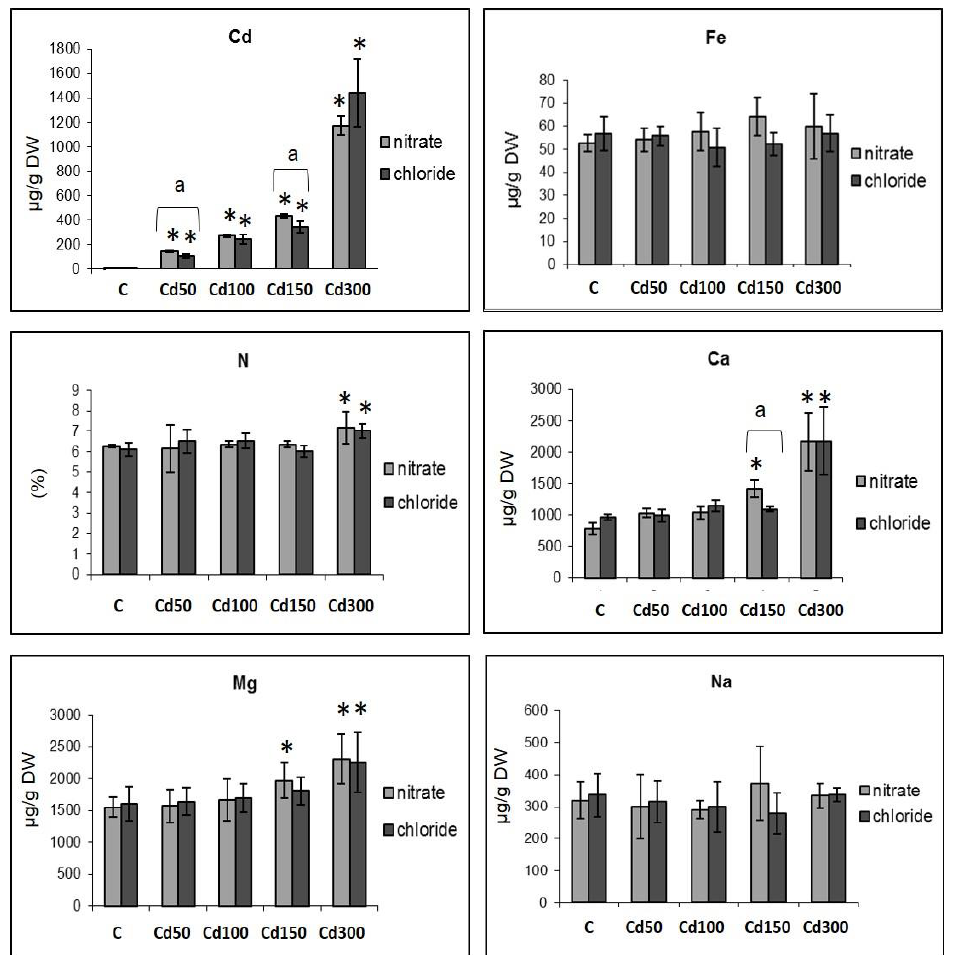
Figure 3. Effects of different doses of cadmium (0–300 mg/L) applied in the form of nitrate or chloride on the content of cadmium ( Cd ) and minerals—iron ( Fe ), nitrogen ( N ), calcium ( Ca ), magnesium ( Mg ) and sodium ( Na )—in roots of fava bean. The values represent the arithmetic mean ± standard deviation. *—the level of significance of the differences against the control (0 mg/L Cd) at p < 0.05; a—statistically significant differences between the variants of the experiment (nitrate and chlo-ride) at p < 0.05.